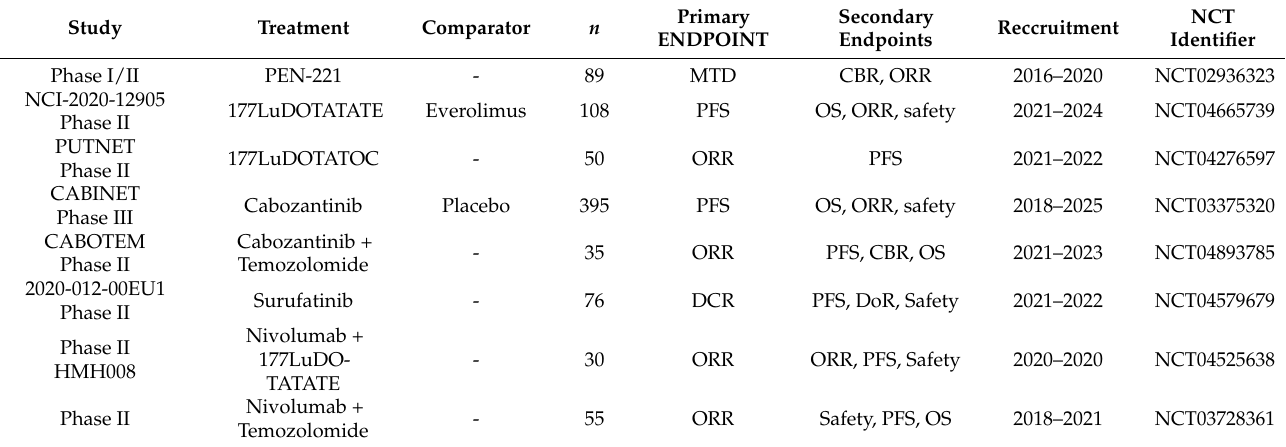
Table 3. Ongoing clinical trials in lung